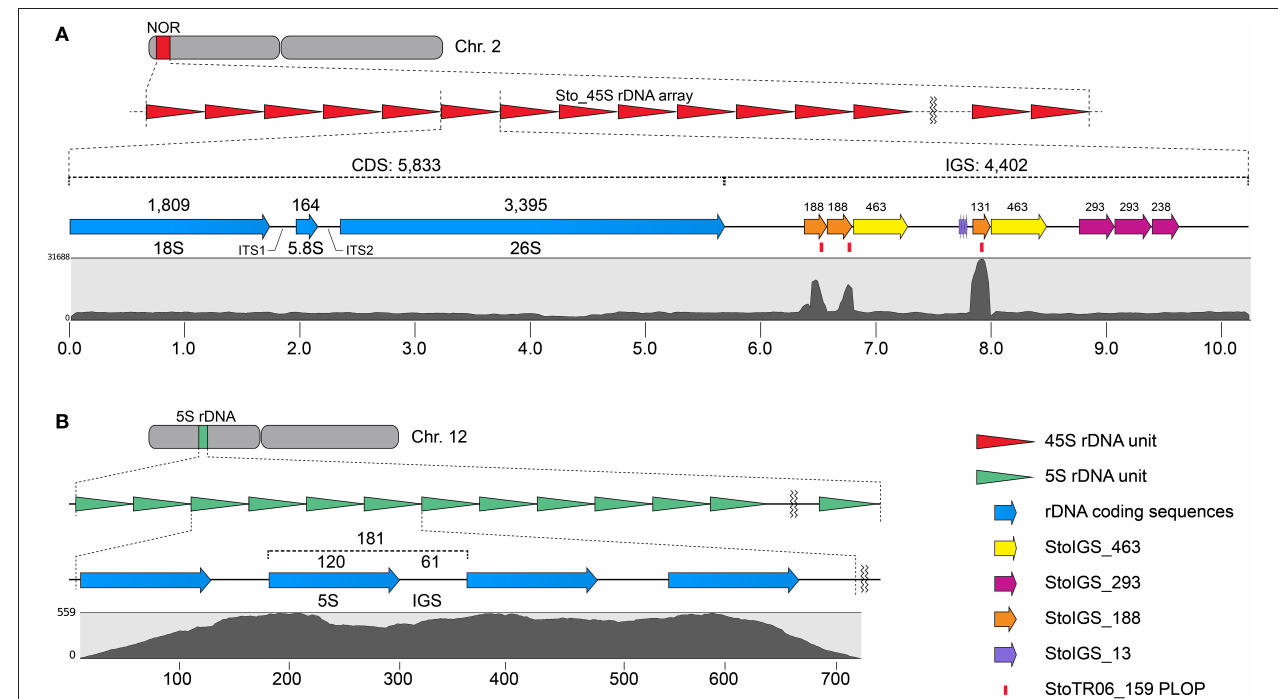
FIGURE 2 | Sequence organization of the 45S (A) and 5S (B) rDNA sequences in S. tora . (A) 10,235 bp S. tora 45S rDNA consensus sequence in chromosome 2. The StoIGS_463 (yellow arrows) was localized immediately downstream of the StoIGS_188 repeat arrays. Mapping of 2.7 × short reads (gray graph) revealed an extreme mapping abundance of the StoIGS_188 coincidentally matching with the StoTR06_159 PLOPs (red bars). (B) 181 bp 5S rDNA in chromosome 12. The numbers on top indicate the bp lengths of corresponding fragments. Scales in (A) and (B) are in kb and bp, respectively.